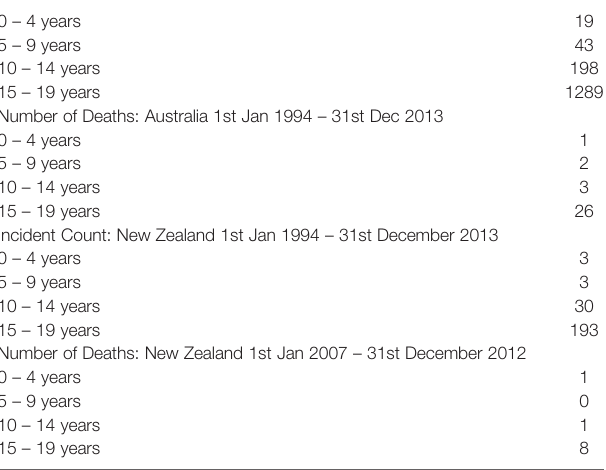
TABLE 2 | Incidence Count from 1 st Jan 1994 – 31 st Dec 2013, based on Australia and New Zealand national cancer registry